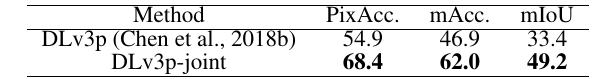
Figure 4. A modified DeepLab v3+ that jointly learns to restore reflectance.